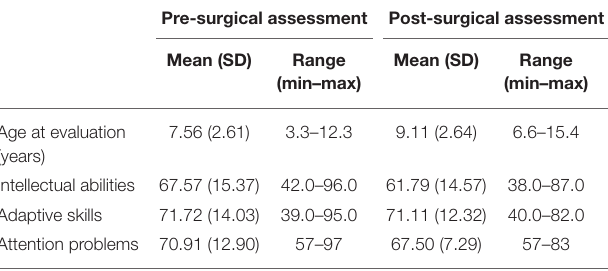
TABLE 3 | Group means of intellectual, adaptive and behavioral